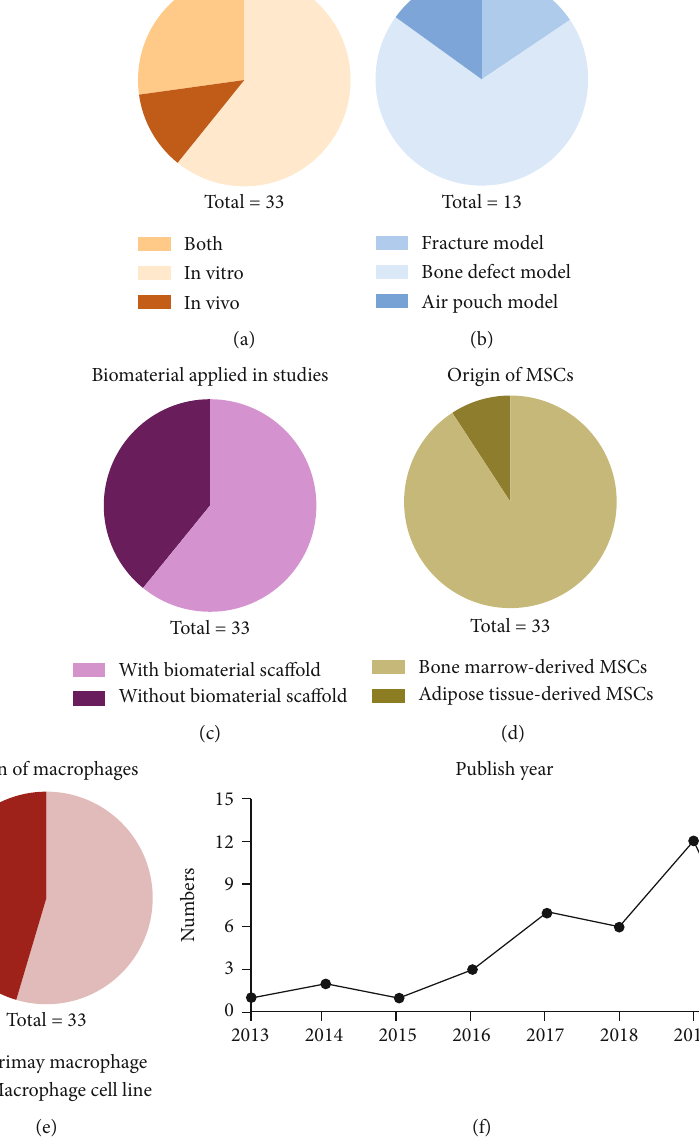
Figure 2: Study characteristics of the systematic review. (a) Categories of experiments. (b) Animal models of the in vivo studies. (c) The origin of the MSCs applied in studies. (d) The origin of macrophages applied in studies. (e) The proportion of biomaterials used in studies. (f) Published year of selected studies. Database searching and study identi fi cation in this review are till Jan of